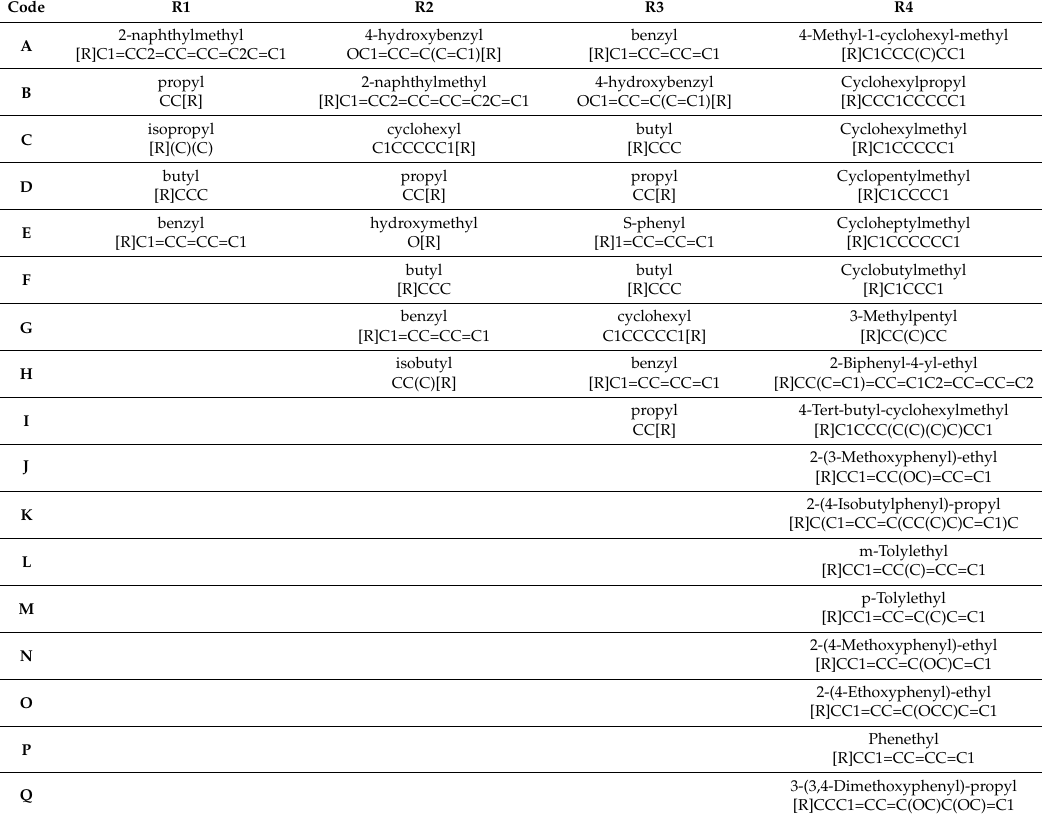
Molecules 2018 , 23 , x FOR PEER REVIEW